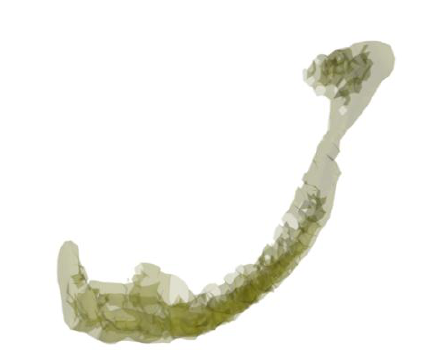
Fig.4 The image of the sliced one layer (High concentration areas in a layer are shown by the thick color.